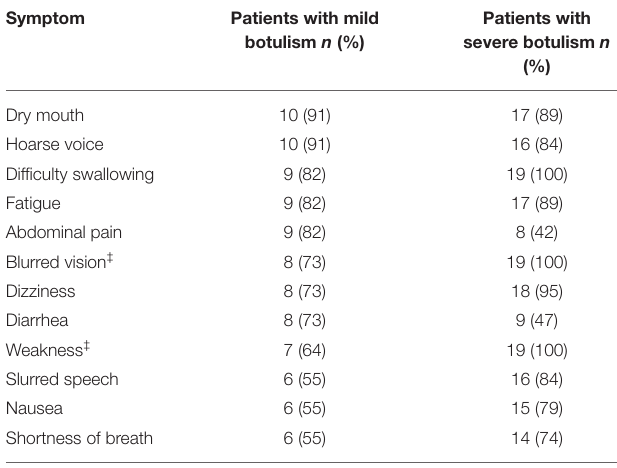
TABLE 1 | Signs and symptoms reported by patients with mild botulism ( N = 11) and patients with severe botulism ( N = 19) * in a large prison outbreak linked to illicitly brewed alcohol—Mississippi, 2016 †